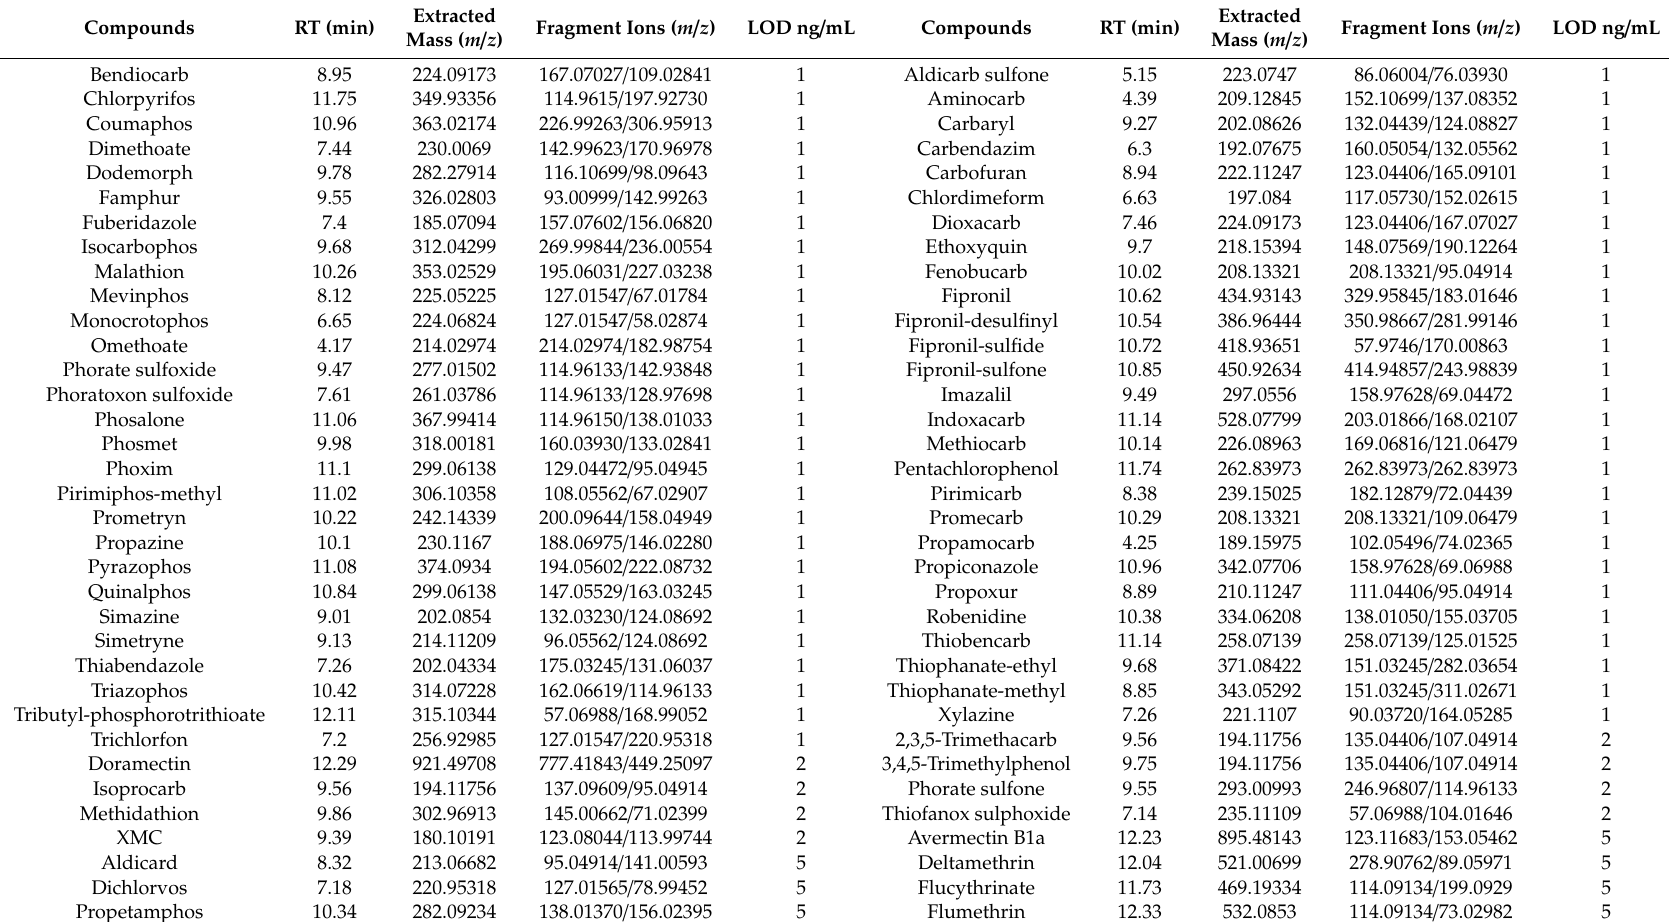
Table 3. Chromatographic, mass spectrometric information and limit of detection of 89 targeted